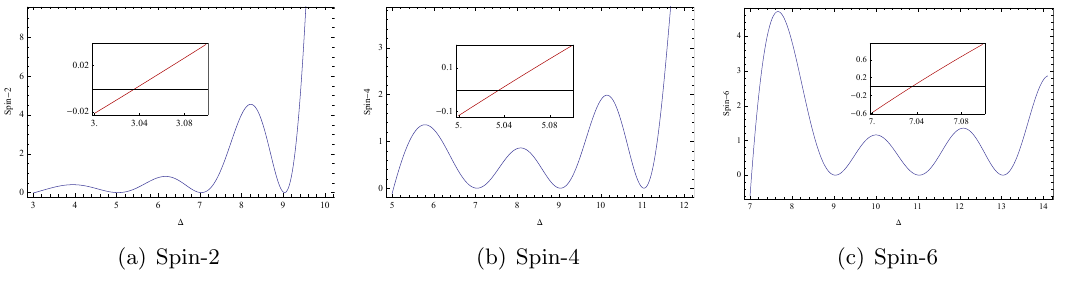
Figure 4 . Plots showing the variation of spin-2,4 and 6 blocks (sum of all three channels) as a function of the dimension of the exchanged operator dimensions ((cid:1)). All of these plots are mostly positive except for near the unitarity bound given by (cid:1) (cid:25) d (cid:0) 2+ ‘ . The sign (cid:13)ip near the unitarity bound is given by the inset